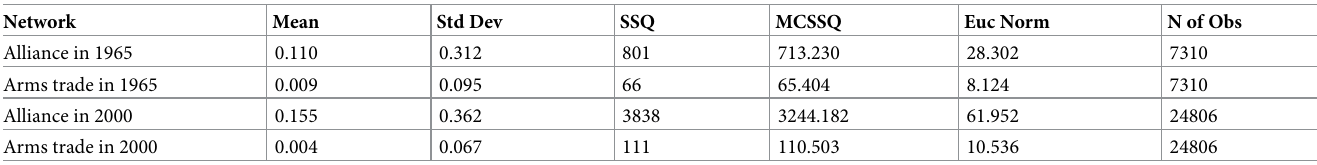
Table 2. Univariate statistics of